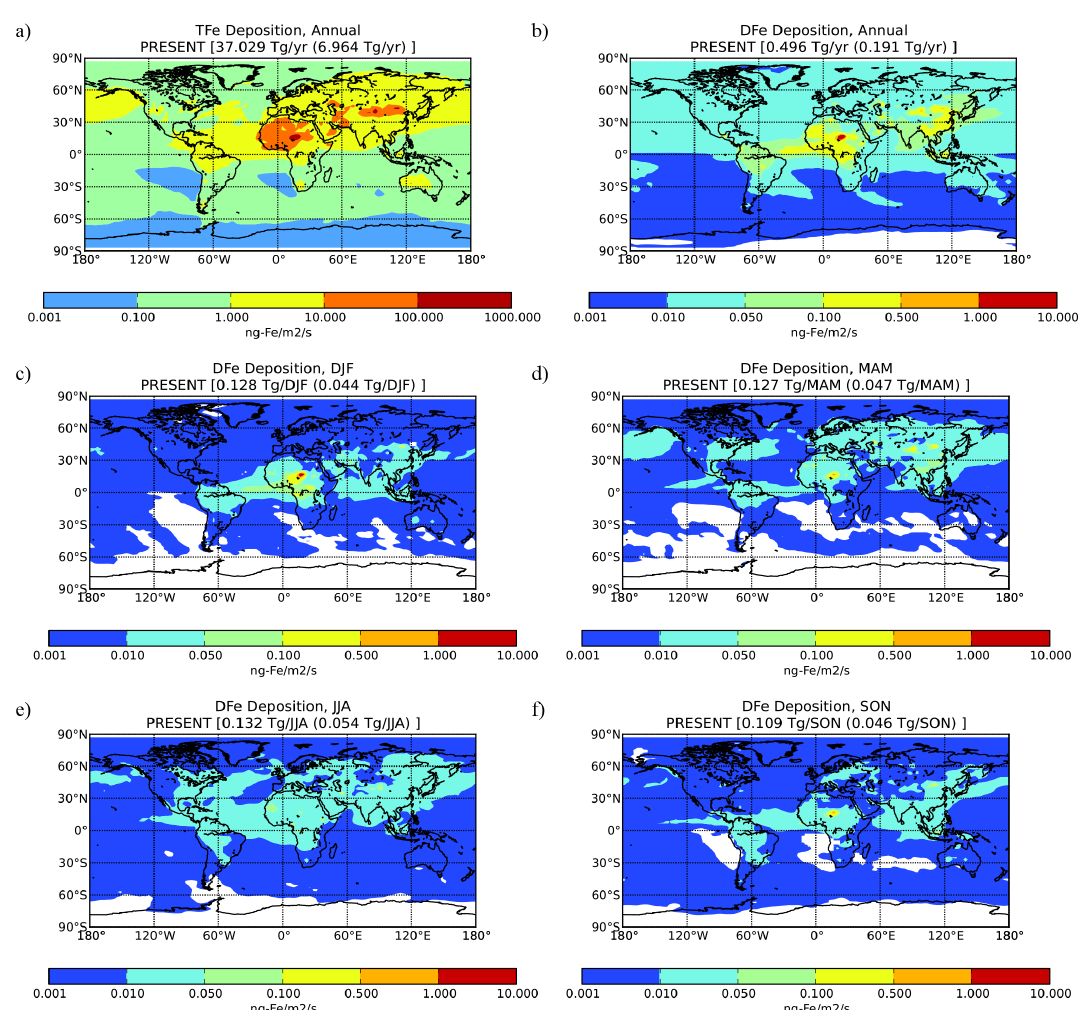
Figure 6. Calculated present annual deposition (in ng-Fem − 2 s − 1 ) for (a) TFe, (b) DFe, and the seasonal DFe deposition fluxes for (c) December, January and February (DJF), (d) March, April and May (MAM), (e) June, July and August (JJA) and (f) September, October and November (SON). In brackets (parentheses) the amounts of Fe deposition over the globe (only over oceans) are